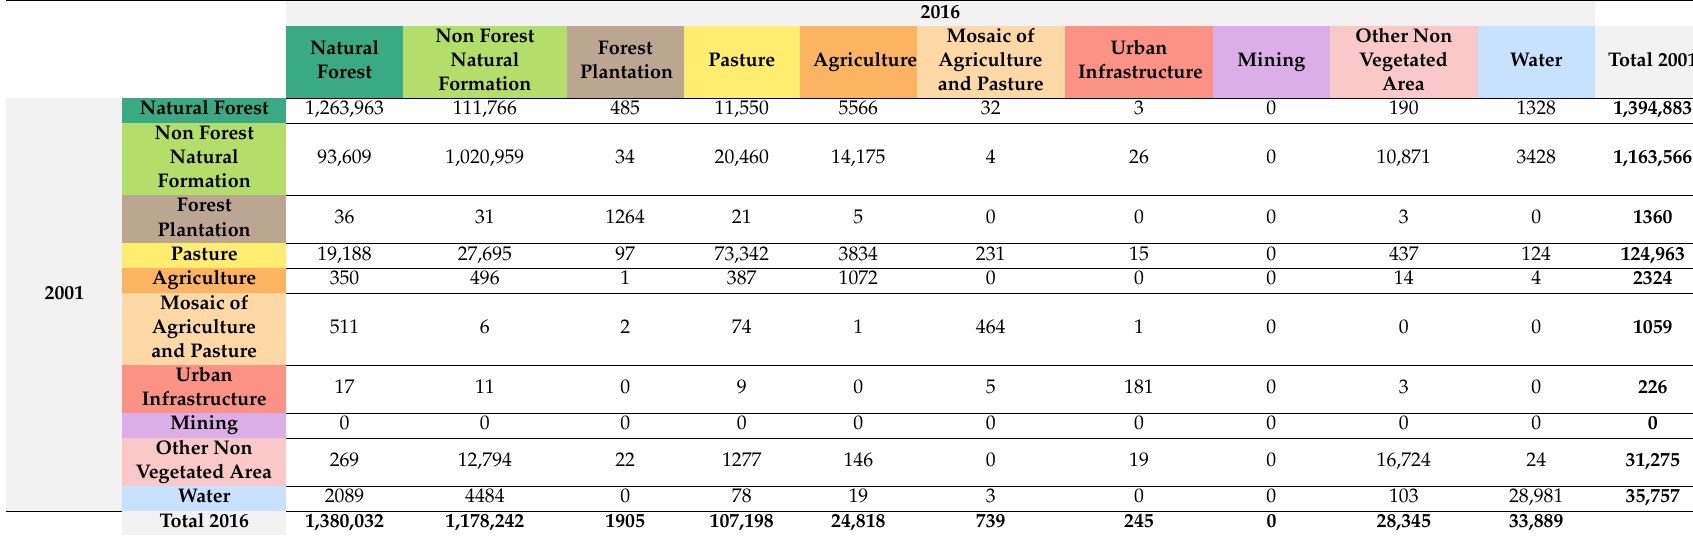
Table A4. LULC transition matrix of the CUs. Entries correspond to the surface area expressed in